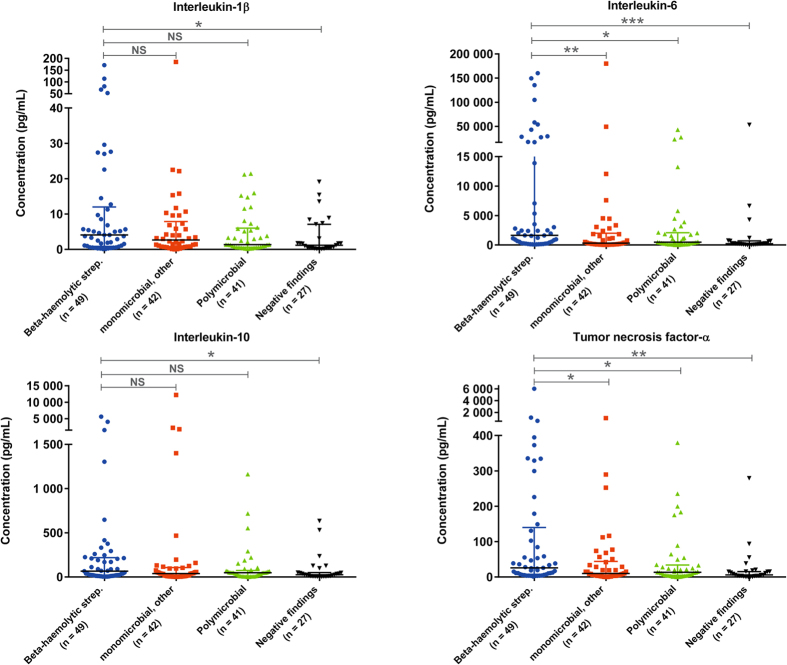
Levels of plasma cytokines on admission according to microbial aetiology in patients with necrotising soft tissue infection.Median with interquartile range is illustrated. Comparisons were performed using the Mann-Whitney U test. NS, non-significant; *p < 0.05; **p < 0.01; ***p < 0.0001. Monomicrobial infection, other includes Staphylococcus aureus, Enterococcus faecium, Escherichia coli, Clostridium septicum, Clostridium perfringens, Corynebacterium amycolatum or gram-negative rods (unspecified). In 19 of the 41 polymicrobial cases, β-haemolytic Streptococcus was part of the infections (group A, n = 11; group B, n = 3; group C, n = 2; group G, n = 2; group C + G, n = 1).